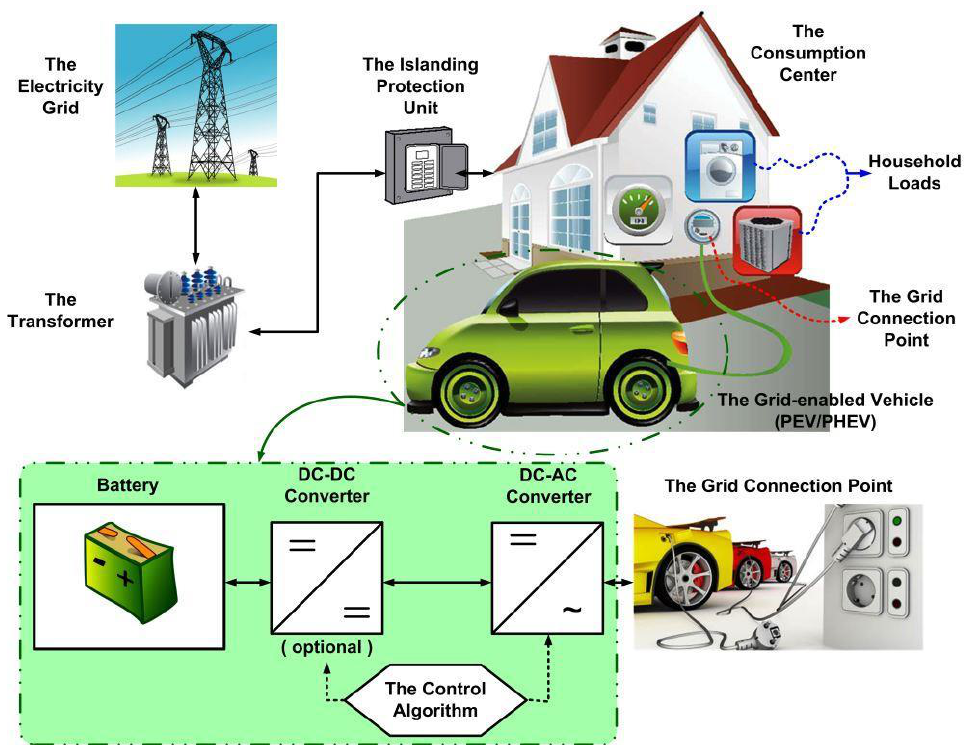
Figure 1. Block scheme of the V2H operating condition.